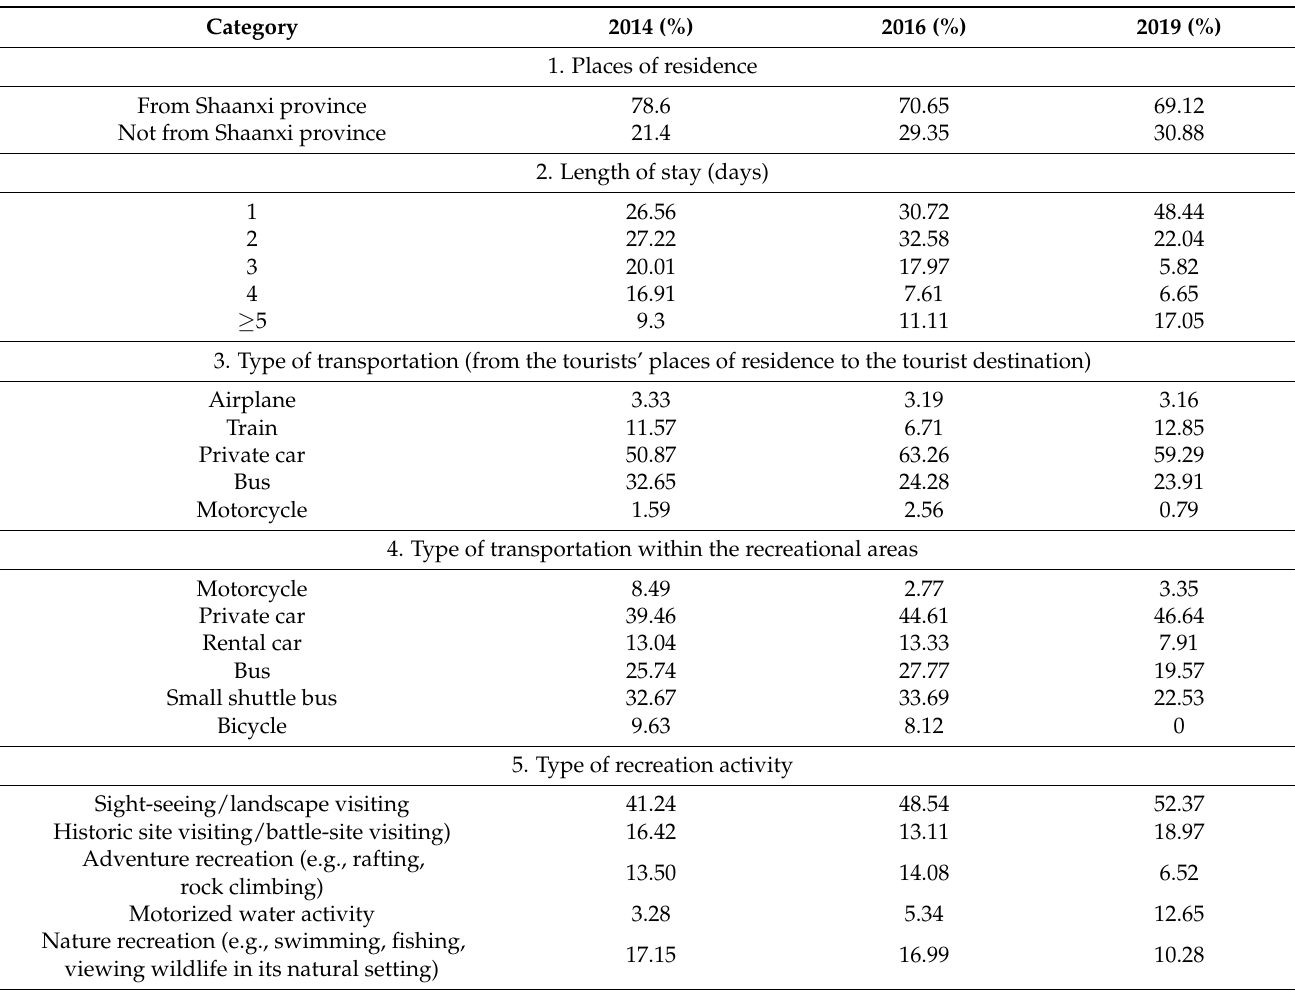
Table 1. The basic information given by tourists to the Qinling Mountains.